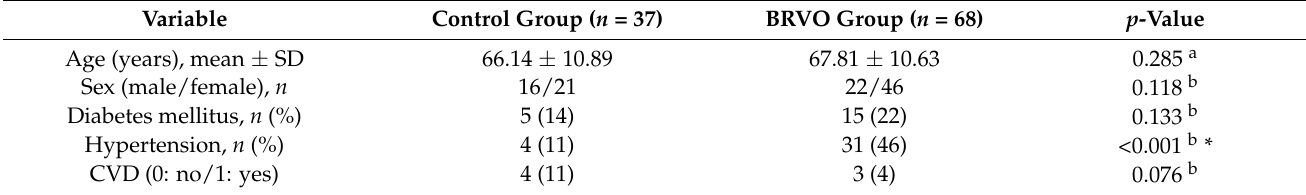
Table 1. Demographic and clinical parameters of normal-tension glaucoma patients with BRVO and controls.